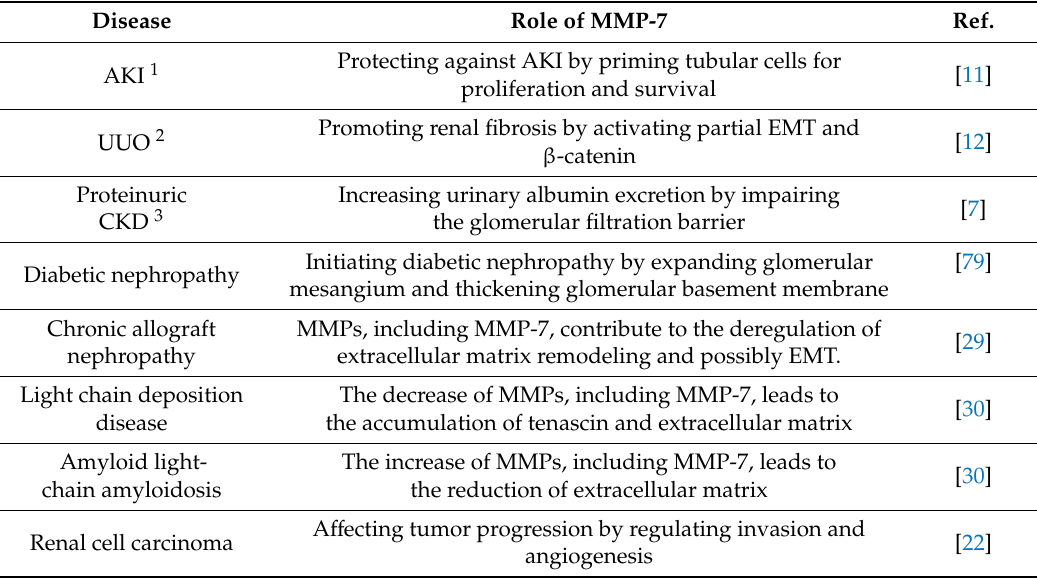
Table 2. Roles of MMP-7 in kidney